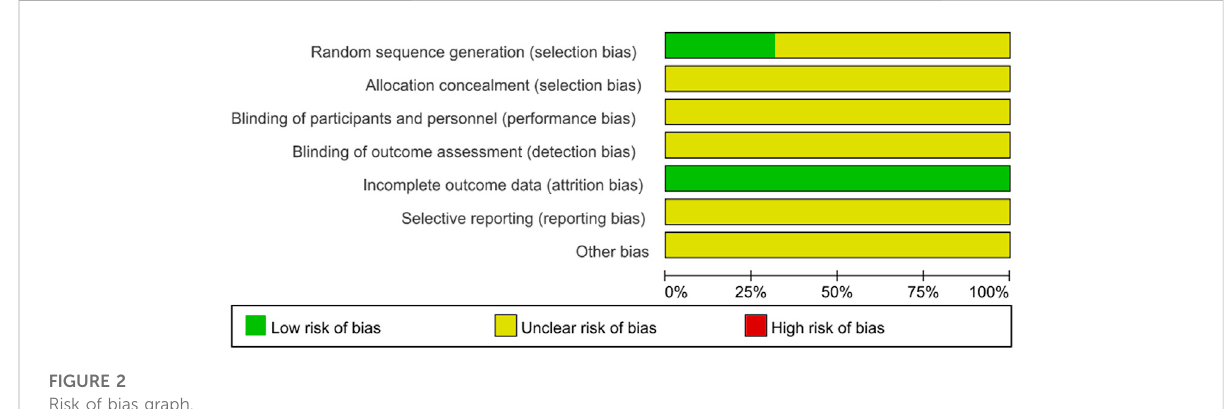
FIGURE 2 Risk of bias